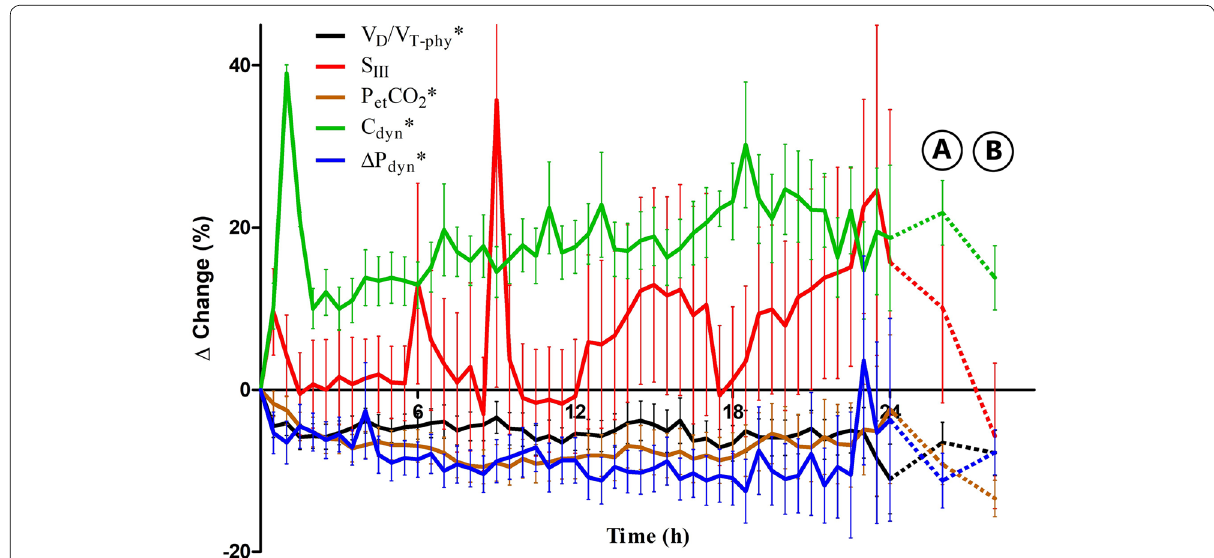
Fig. 1 Evolution of Δ V D / V T‑phy , Δ S III , Δ P et CO 2 and Δ C dyn for each parameter (session 1), from 0 h (just before prone positioning) to 24 h of prone position; Ⓐ at sessions’ end (dotted line); Ⓑ 2 h after return in supine position (dotted line). * p < 0.05 (global time effect